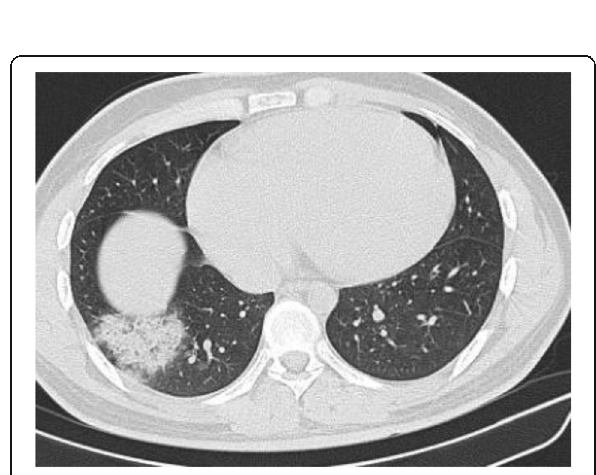
Fig. 5 Patient about 24 days after onset of symptoms. A well- defined area of consolidation/fibrosis seen in the right lower lobe, no other abnormality was noted in both